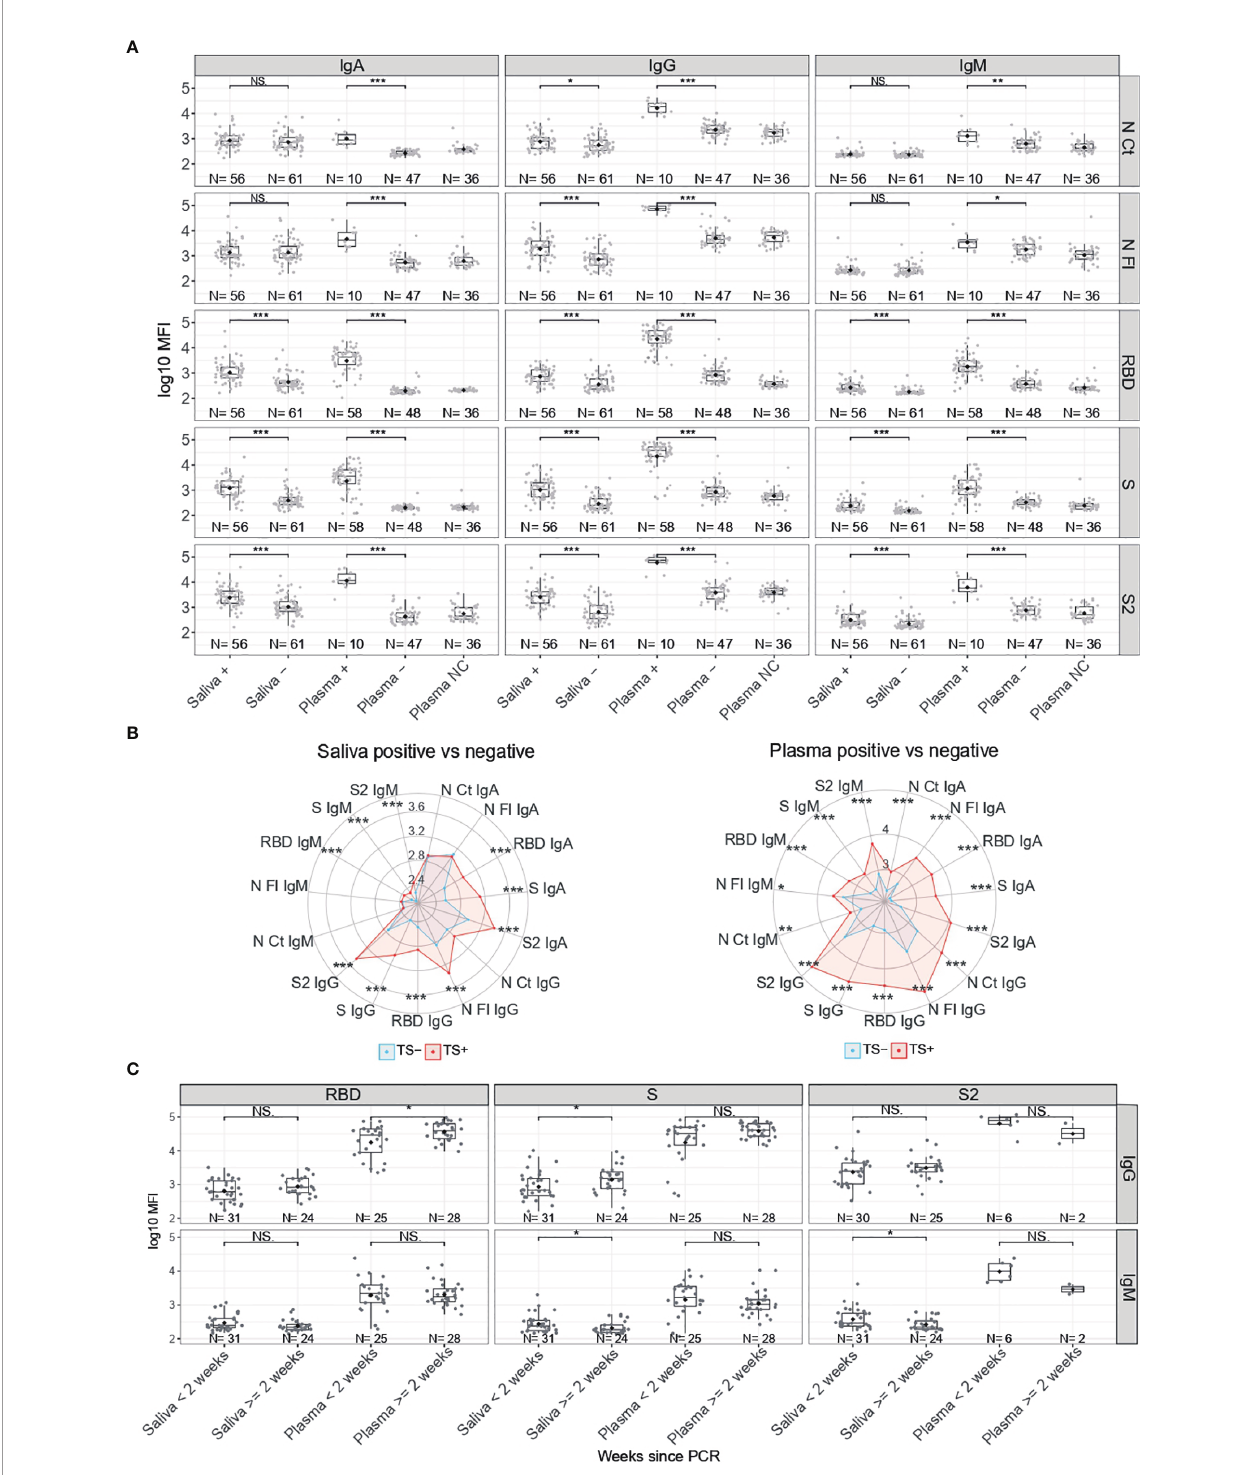
FIGURE 1 | Antibody levels according to SARS-CoV-2 RT-PCR status. (A) Boxplots showing log 10 MFI antibody levels. Saliva samples were tested heat inactivated and at 1/10 dilution, and serum (from plasma samples or dry blood spots) at 1/500. (B) Radar charts representing the median of the log 10 MFI antibodies in plasma and saliva. TS-: Negative Test Sample, represented in blue. TS+: Positive Test Sample, represented in red. (C) Boxplots showing log 10 MFI antibody levels by time since positive RT-PCR. Median log 10 MFI levels were compared by Mann-Whitney U test. Statistically signi fi cant raw p-values are highlighted with asterisks. ***p < 0.001, **p < 0.01, *p < 0.05, NS, Not signi fi